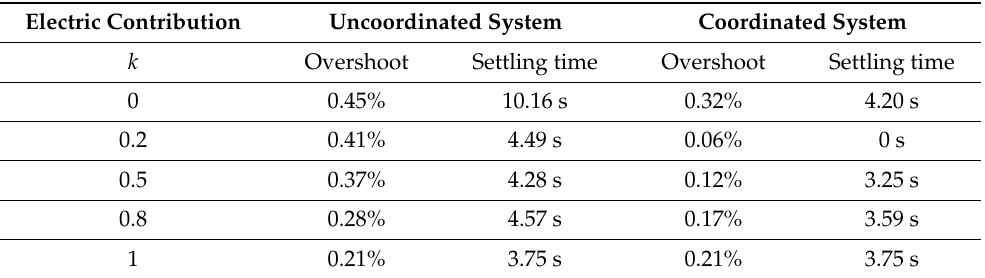
Table 3. Overshoot and settling time of Transient #3 vs. electric contribution (